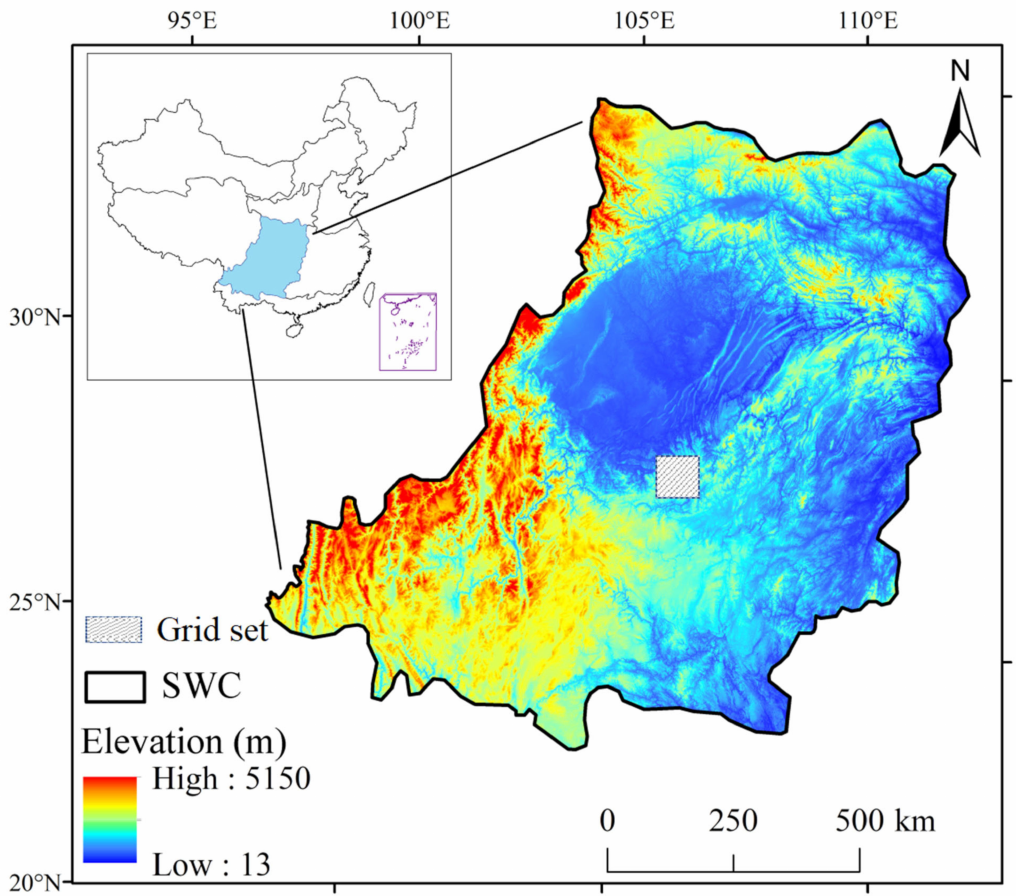
Figure 1. The location of the study site (grid